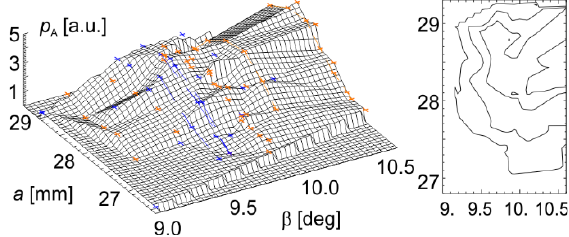
Fig. 14. Pulse amplitude response of one thermocouple on the reflecting grating of Gyrotron #8 to TORBEAM [8] evaluated O-2 mode shine through power as a function of the push-rod position a [mm] and the rotation of the mirror support around the push- rod β [deg]. The plot on the left was generated using Delauney triangulation and corresponding visualization [7] for irregularly gridded data. Individual measurements are plotted in orange (2017 campaign) and blue (2019 campaign). Points connected with a dashed line are from a launcher sweep as described in section 4.1. The inset on the right is a contour plot of the same data, with contour levels 0.9, 1.8, 2.7 and 3.6. Within the plot range of a [mm], the centre of the beam moves approx. 10 cm on the heat shield, and approx. 7 cm within the plot range of β. The coordinates are only approximative ly corresponding to the vertical and horizontal directions, because the geometry is oblique (cf. figure